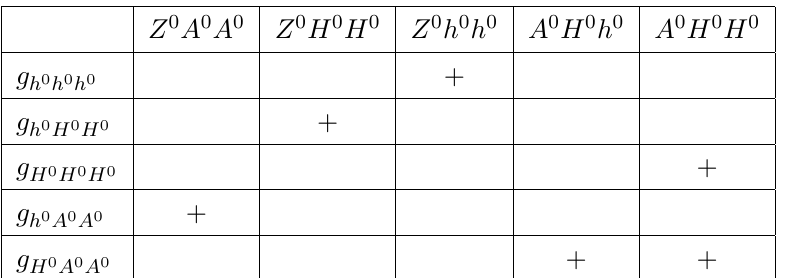
Table 2 . The trilinear Higgs self-couplings contributing to each scattering process in a future linear collider. The exact alignment s (cid:12)(cid:11) = 1 and m H = m